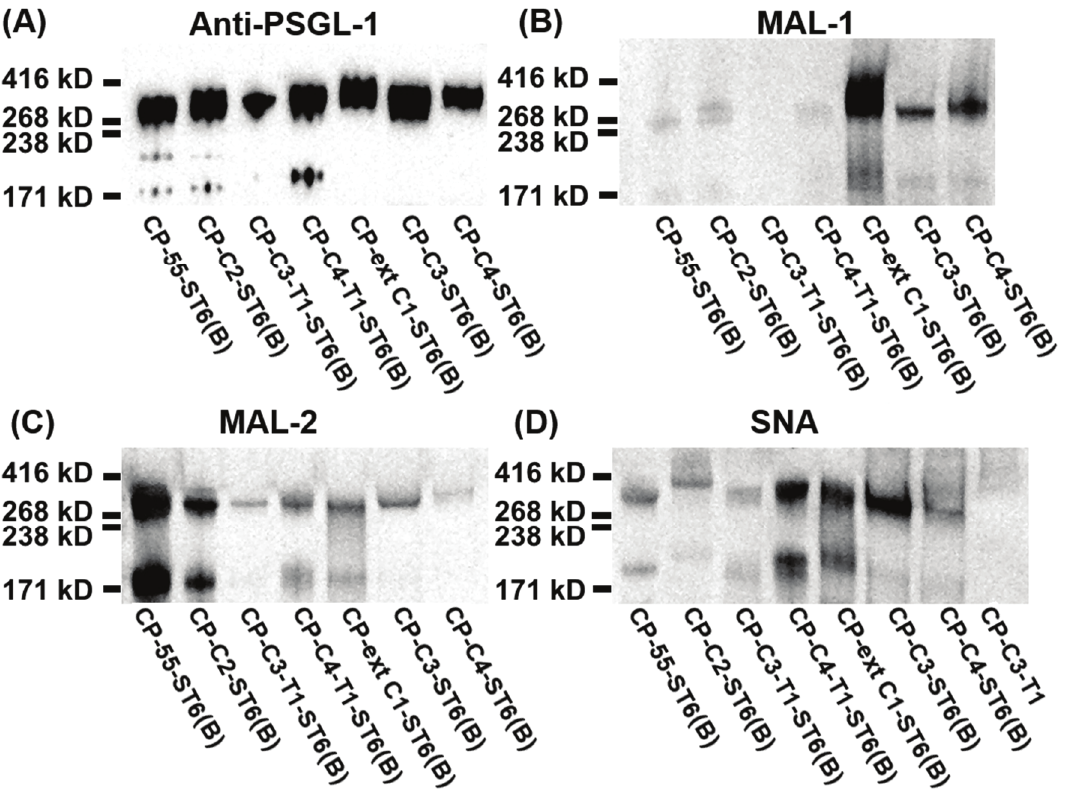
Figure 6. SDS-PAGE and lectin blot analysis of purified PSGL-1/mIgG2b carrying (cid:2)2,6-linked sialic acid on different O -glycan core structures. For Western blot analyses, 0.2 μ g of recombinant protein were loaded and analyzed on SDS-PAGE under non-reducing conditions. After blotting, membranes were probed with anti-PSGL-1 ( A ), MAL-1 ( B ), MAL-2 ( C ), and SNA ( D